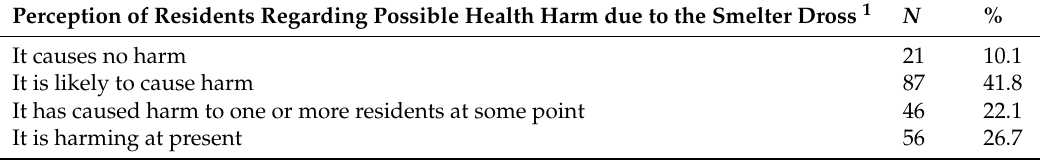
Table 2. The smelter dross ability to harm the health of people living in the household according to the opinion of 208 residents in Santo Amaro City,